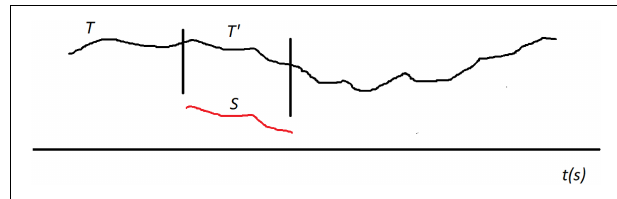
FIGURE 4 | Searching for best matching location between the shapelet S (red) and the segment T (black). Shapelet is translated (shifted) along T from the start to the end, step by step (point by point). At each location we measure the distance D between S and the corresponding chunk (sub-segment) of the whole segment T , which we generically denote with T ’. The length of T ’ is always equal to the length of S . In this illustration the best matching location of T ’ is shown, where the distance D is minimal. This minimal distance D is then taken as the distance δ between S and T .